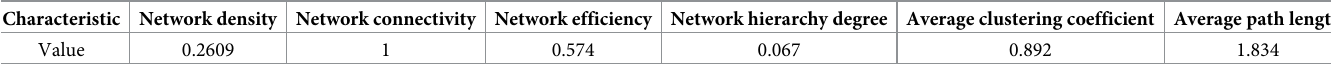
Table 2. Whole network characteristics of China’s green